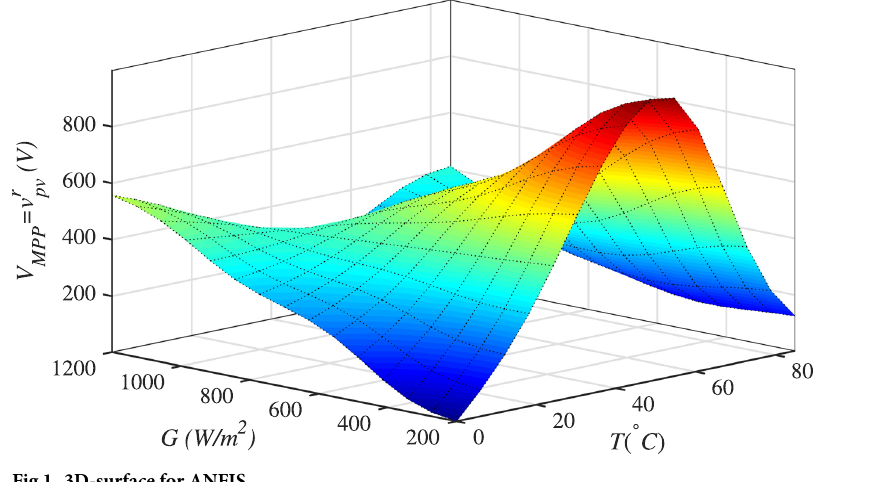
Fig 1. 3D-surface for